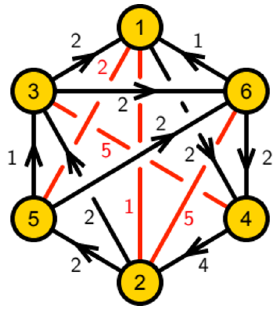
Figure 16 . Quiver for Model